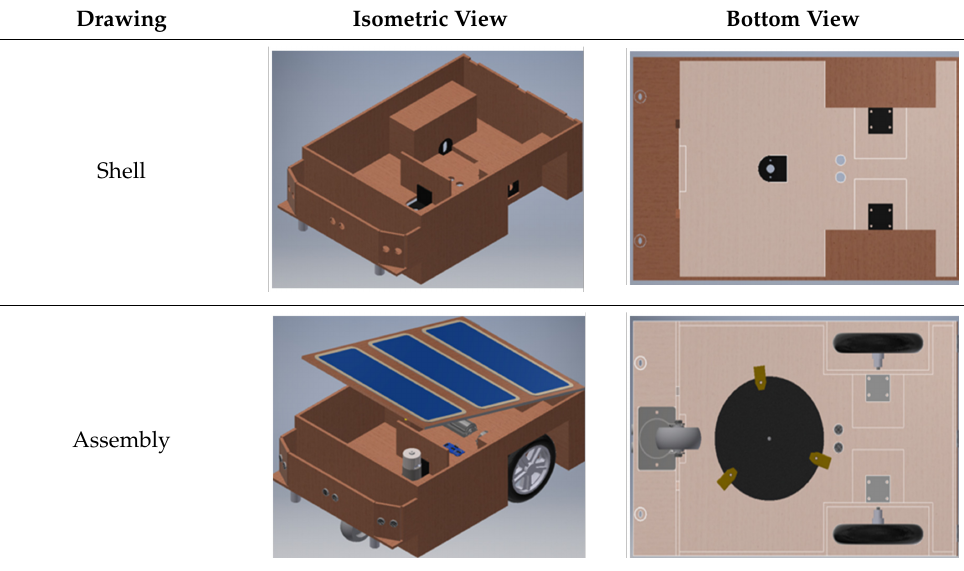
Table 21. Isometric and bottom view of the lawnmower (shell and